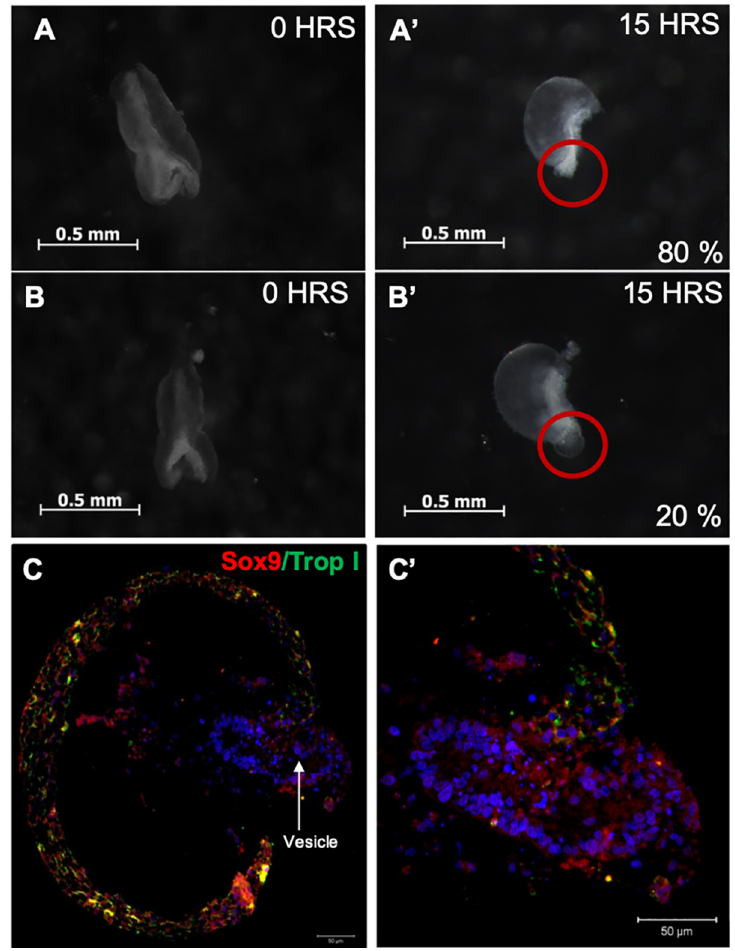
Fig 3. Representative images of the in vitro explants assays showing that the atria did not arise from the first heart field-derived straight heart tube. (A and B) Recently explanted straight heart semi-tubes (HH10). (A’ and B’) The same hearts after 15 h of in vitro culture. The C-looped heart tubes and a new vesicle formed at their caudal limit. (C) Panoramic view of a C loop showing the presence of cytoplasmic Troponin I (green fluorescence) and Sox-9 (red fluorescence) in cells along the cardiac tube. (C’) Newly formed cardiac vesicles at the caudal end of C loop comprising cells expressing nuclear Sox-9